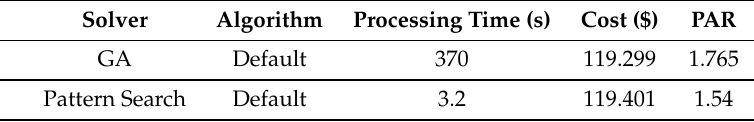
Table 4. Solvers performance for a single